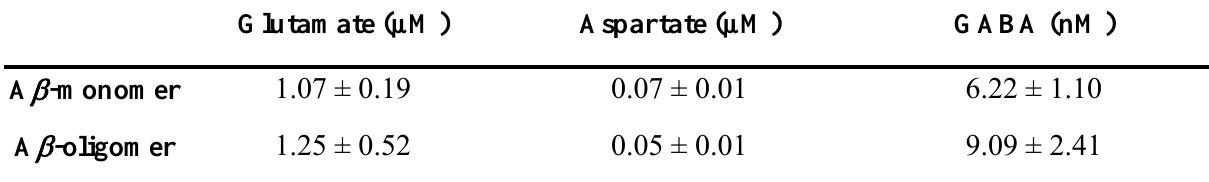
Table 1. Basal dialysate glutamate, aspartate and GABA levels (absolute levels) in dorsal hippocampus measured prior to ipsilateral icv injection of either the A  monomer or oligomer. Each value represents the mean ± standard error of the mean ( SEM) of three consecutive 20 min dialysate fractions (60min) collected prior to ipsilateral icv A β injection (n= 5-7 animals per